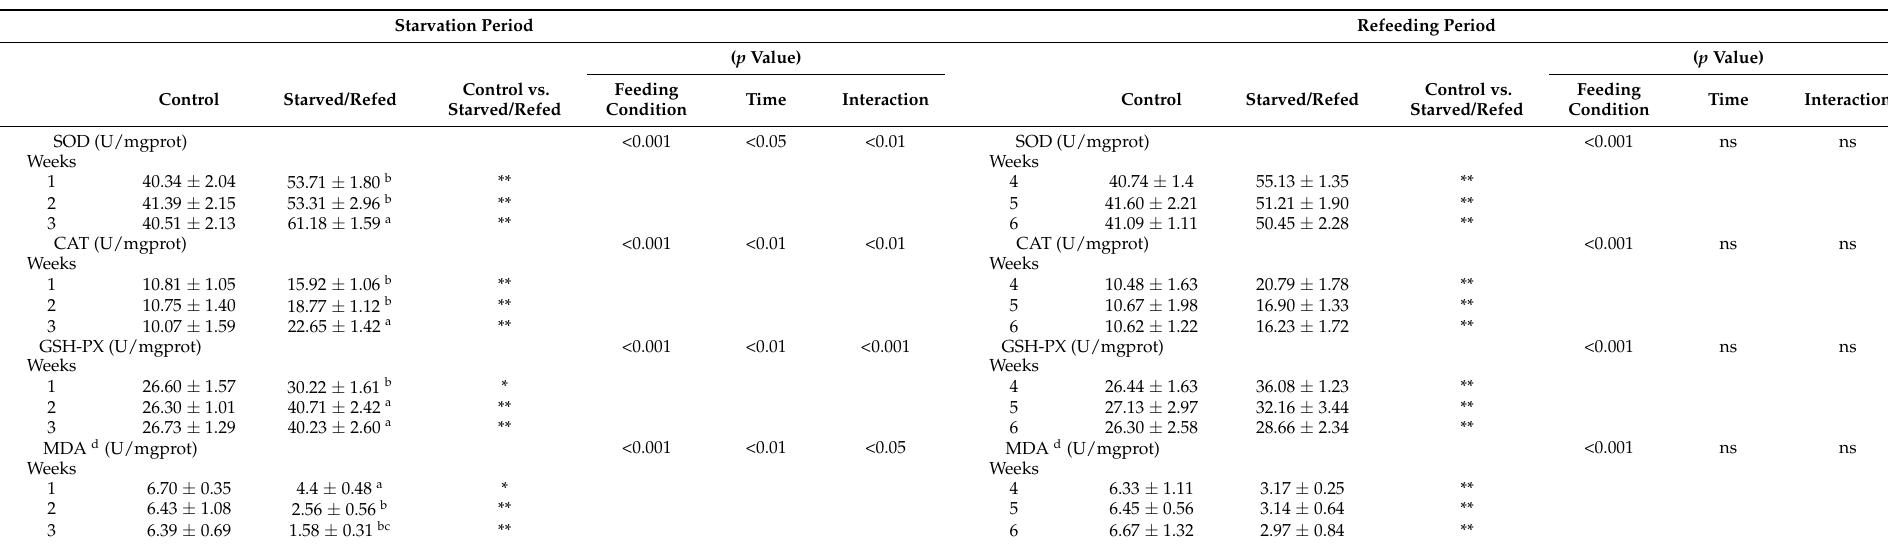
Table 9. Intestinal antioxidant indices of O. macrolepis exposed to starvation and refeeding